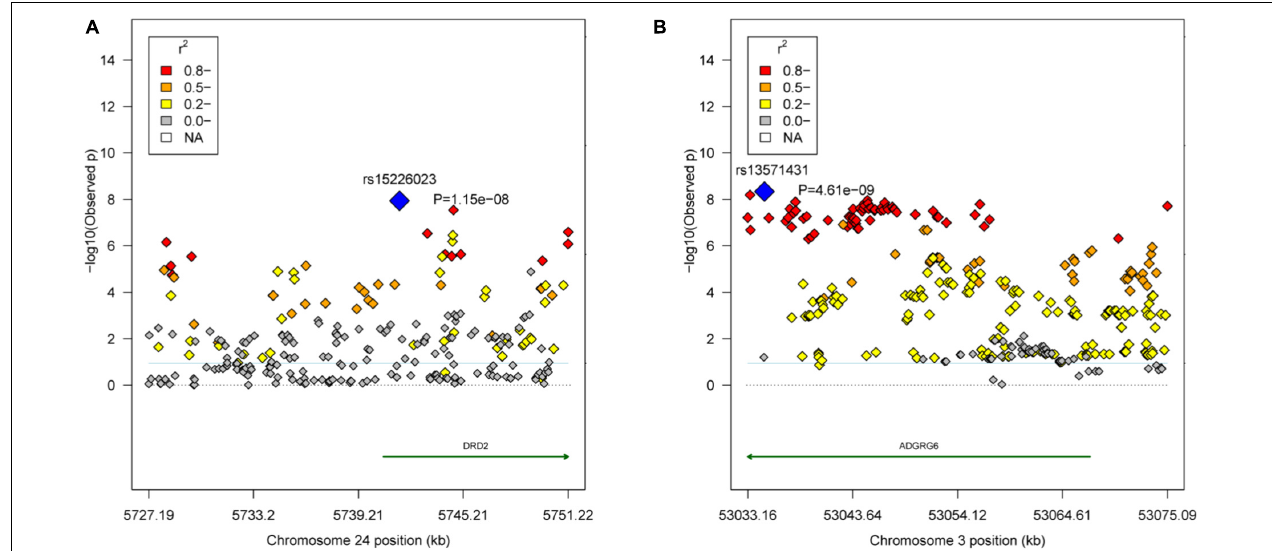
FIGURE 3 | Regional association plots of the candidate areas. (A) The QTL region GGA24: 5.73–5.75 Mb associated with the weight traits. The blue dot represents the lead SNP rs15226023. (B) The QTL region GGA3: 53.03–53.08 Mb associated with the carcass composition traits. The blue dot represents the lead SNP rs13571431. Different levels of linkage disequilibrium (LD) between the lead SNP and the surrounding SNPs are shown in different colors (red: r 2 ≥ 0.8; orange: 0.5 ≤ r 2 < 0.8; yellow: 0.2 ≤ r 2 < 0.5; and gray: r 2 < 0.2). The gene annotations were obtained from the University of California Santa Cruz (UCSC) Genome Browser (http://genome.ucsc.edu).